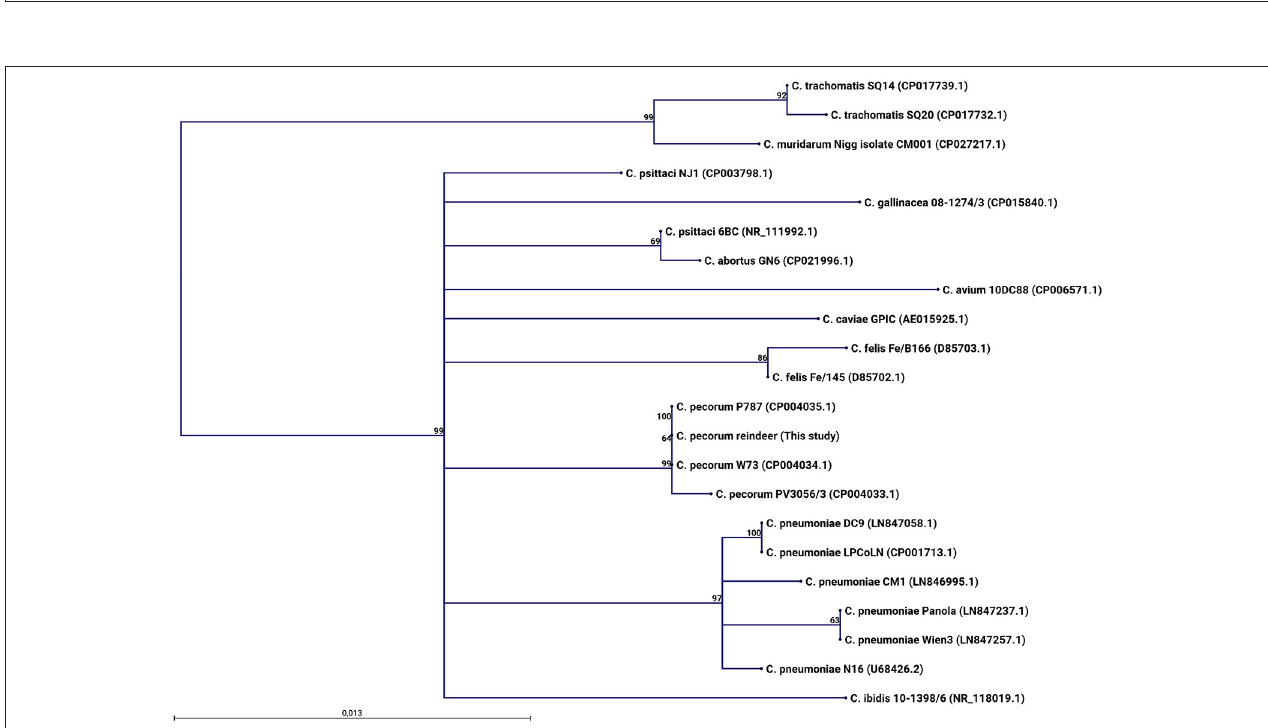
FIGURE 3 | A maximum likelihood phylogenetic tree based on alignment of a 427 nucleotides segment of the 16S rRNA gene V3 and V4 variable regions was inferred using the HKY model of sequence evolution. Bootstrap support values > 50 percent obtained from 1,000 replications are indicated next to the relevant nodes. Sequences for the reference Chlamydia species obtained by discontinuous BLASTn searches against the NCBI GenBank database were aligned with the reindeer Chlamydia 16S rRNA gene sequence generated in this study, using the CLC genomics workbench algorithm in the slow and very accurate mode. The P787 (CP004035.1) and W73 (CP004034.1) C. pecorum strains, both isolated from sheep, are identical to the C. pecorum reindeer identified from six DNA pools of 12 animals with clinical signs of IKC in this study, across the gene regions characterized.